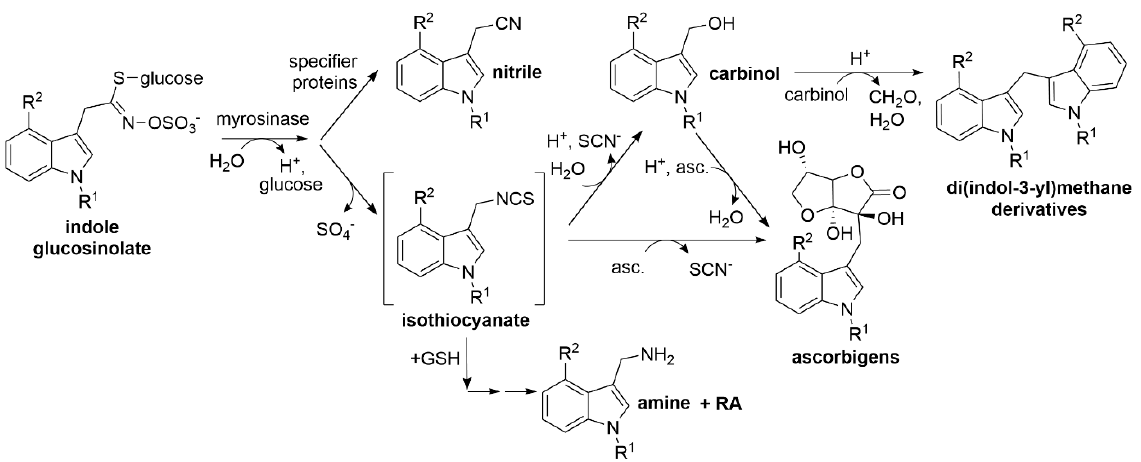
Figure 1. Breakdown of indole glucosinolates. Upon tissue damage or sub-cellular reorganization, indole glucosinolates are hydrolyzed by myrosinases. The aglucones are unstable and rearrange to isothiocyanates which readily react with nucleophiles such as water, ascorbic acid (asc.), and glutathione (GSH) yielding carbinols, ascorbigens, and GSH conjugates, all of which can undergo further reactions. Formation of di(indol-3-yl)methanes or indolic amines and raphanusamic acid (RA) are shown as an example. Ascorbigens can also be formed from carbinols upon reaction with ascorbic acid. Alternatively, the aglucones can be converted to nitriles by specifier proteins. R 1 , R 2 : -H, -OH or -OCH 3 (see Table 1). The reaction scheme has been adapted from [20] with modifications according to [14]. Table 1. Substitution patterns and abbreviations of indole glucosinolates, as well as the derived carbinols and nitriles. The glucosinolates, carbinols and nitriles considered in this study are listed. The core structures are shown in Figure